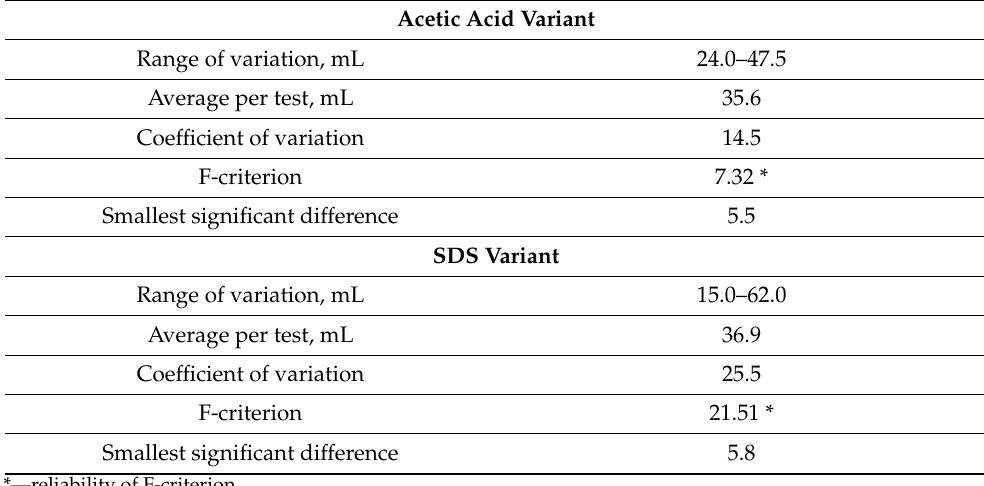
Table 1. Statistical differentiation of grain sorghum samples by the sediment volume.